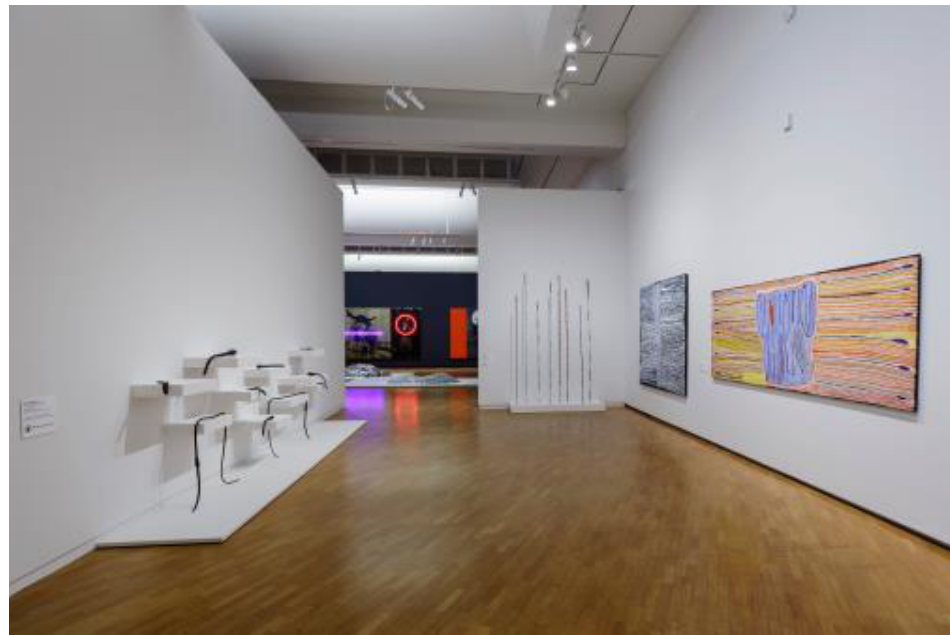
Installation view, Defying Empire: The Third National Indigenous Art Triennial, National Gallery of Australia, Canberra, ACT, photo courtesy of National Gallery of Australia.